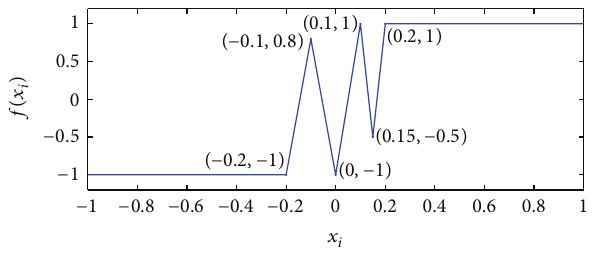
Figure 5: The plot of the piecewise function 𝑓(𝑥 𝑖 ) .